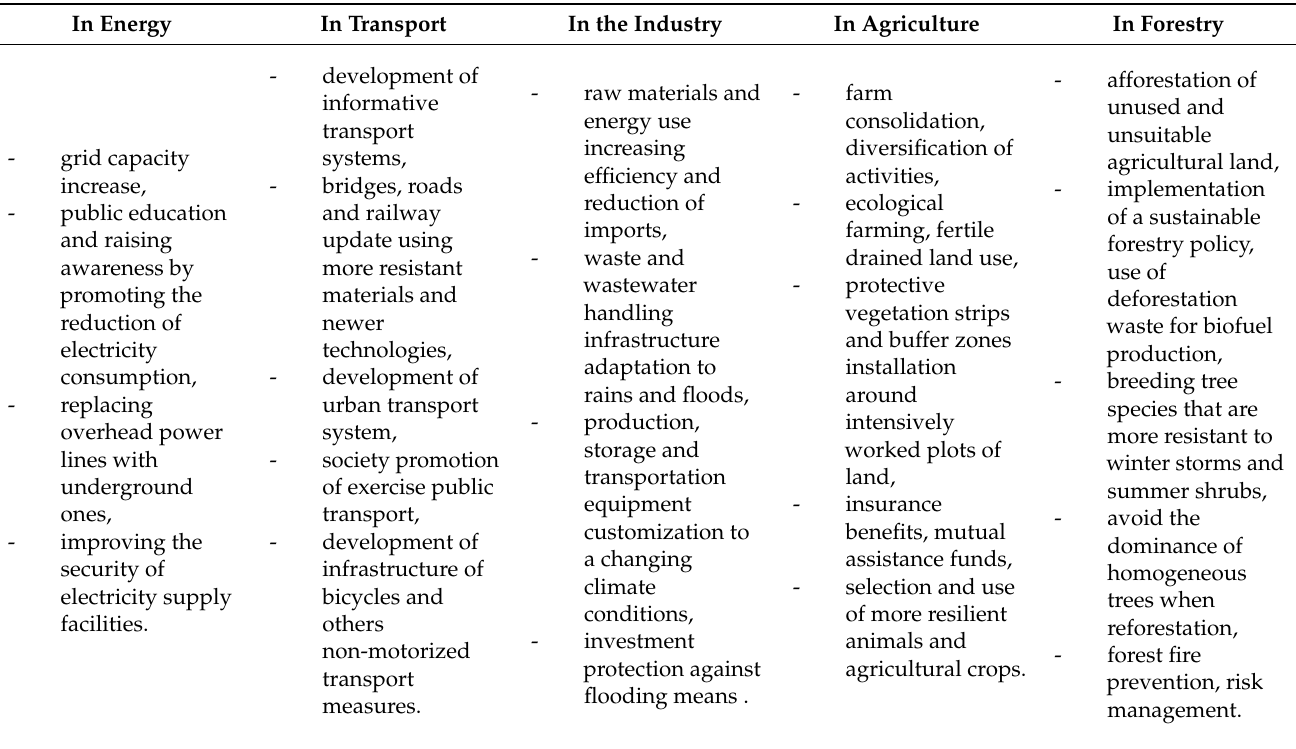
Table 2. Main measures in increasing the efficiency of energy use and reducing pollution in the sectors of the Lithuanian